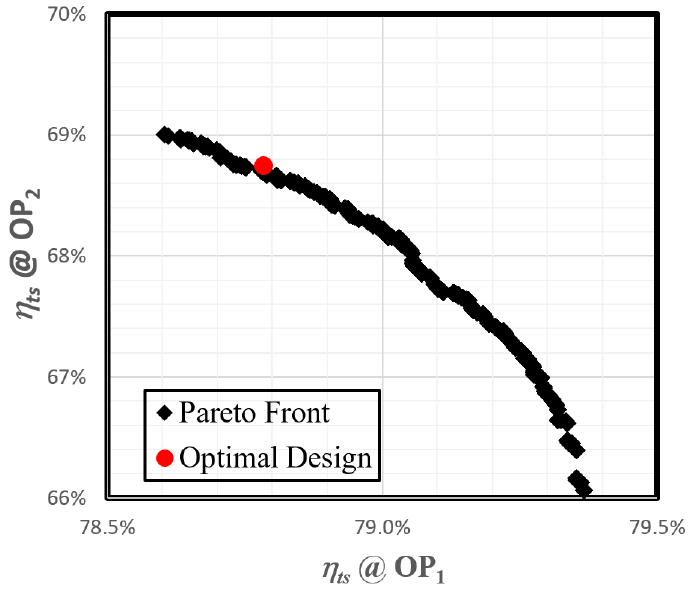
Figure 11. Pareto Front and selected optimal design.